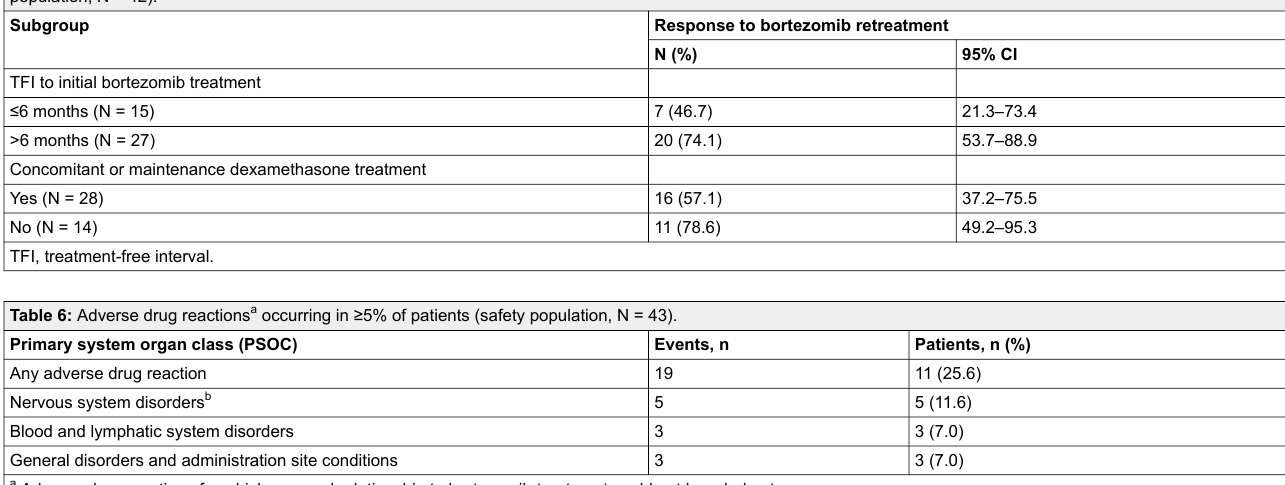
Response to bortezomib retreatmentSubgroup